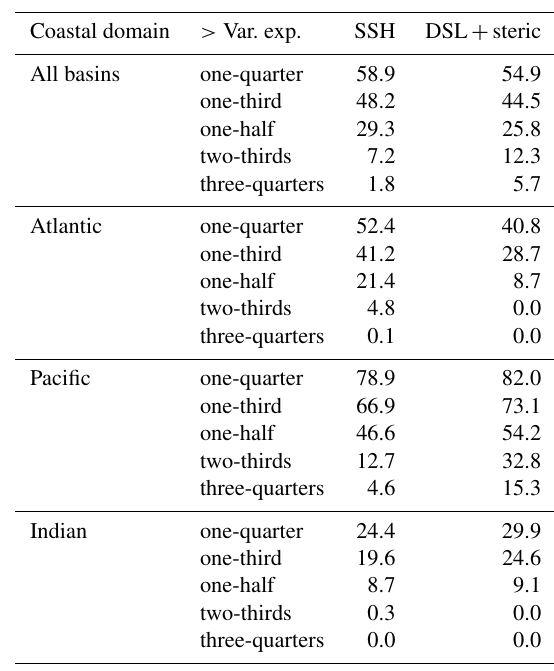
Table 1. The proportion of coastal grid cells defined from the NEMO grid with more than one-quarter (25%), one-third (33%), one-half (50%), two-thirds (67%), and three-quarters (75%) of decadal trend variance explained by the reconstruction. The values shown here are from assessment of the “coastal domain” and the NEMO model runs. “SSH” refers to the reconstruction using EOF and PC modes for the full SSH signal, and “DSL + steric” refers to the reconstruction by component for manometric dynamic sea level, GRD, and steric sea level associated with climate indices separately and then summed.